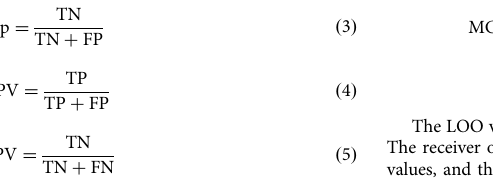
The LOO validation and 4-, 6-, 8-, and 10-fold cross-validations are conducted. The receiver operating characteristic curves are illustrated based on Sn and 1-Sp values, and the AUC scores are calculated.